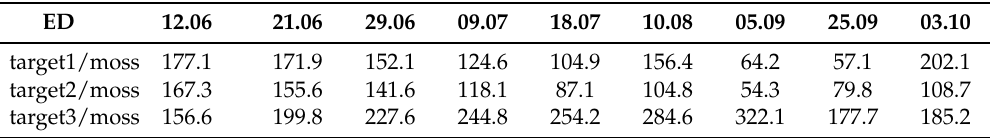
Table 3. The Euclidean Distance (ED) values between the reference spectrum and target spectra during the growth